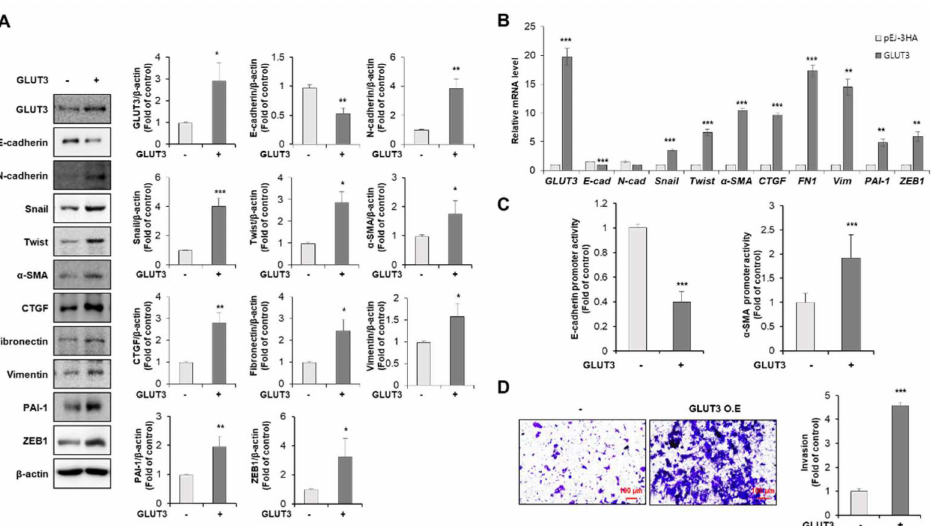
Figure 1. GLUT3 promotes EMT in HCT116 cells. ( A ) HCT116 cells were transfected with GLUT3/pEJ-3HA (2 µ g) for 24 h. Western blot analysis was performed to measure the protein levels of GLUT3, E-cadherin, N-cadherin, snail, twist, α -SMA, CTGF, fibronectin, vimentin, PAI-1 and ZEB1. ( B ) qRT-PCR was performed to measure the mRNA levels of GLUT3, E-cadherin (E-cad), N-cadherin (N-Cad), snail, twist, α -SMA, CTGF, fibronectin 1 (FN1) and vimentin (Vim), PAI-1 and ZEB1. ( C ) The E-cad-Luc or α -SMA-Luc plasmids were transfected with GLUT3/pEJ-3HA into HCT116 cells for 24 h. Cell extracts were harvested, and the luciferase assay was performed. ( D ) Cell invasion was analyzed after 48 h post transfection with GLUT3/pEJ-3HA (2 µ g) to allow for the permeabilization of the transwell membrane. The membrane was stained with 0.2% crystal violet. Scale bar, 100 µ m. GLUT3, glucose transporter 3; α -SMA, α -smooth muscle actin; PAI-1, plasminogen activator inhibitor-1; ZEB1, zinc finger E-box binding homeobox 1, qRT-PCR, quantitative reverse transcription PCR; CTGF, connective tissue growth factor. Data are the mean ± standard deviation. Statistical significance was analyzed by analysis of variance. * p < 0.05, ** p < 0.01, and *** p < 0.001, significantly different compared with